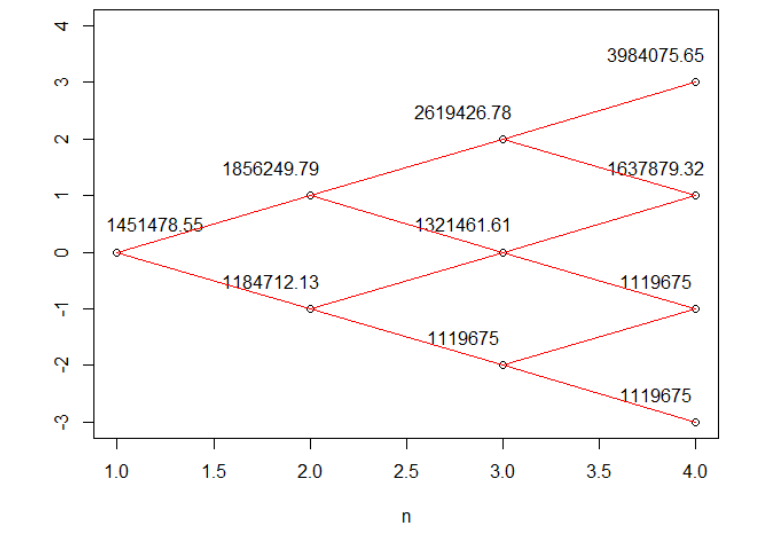
Figure 5. Tree 2 option to